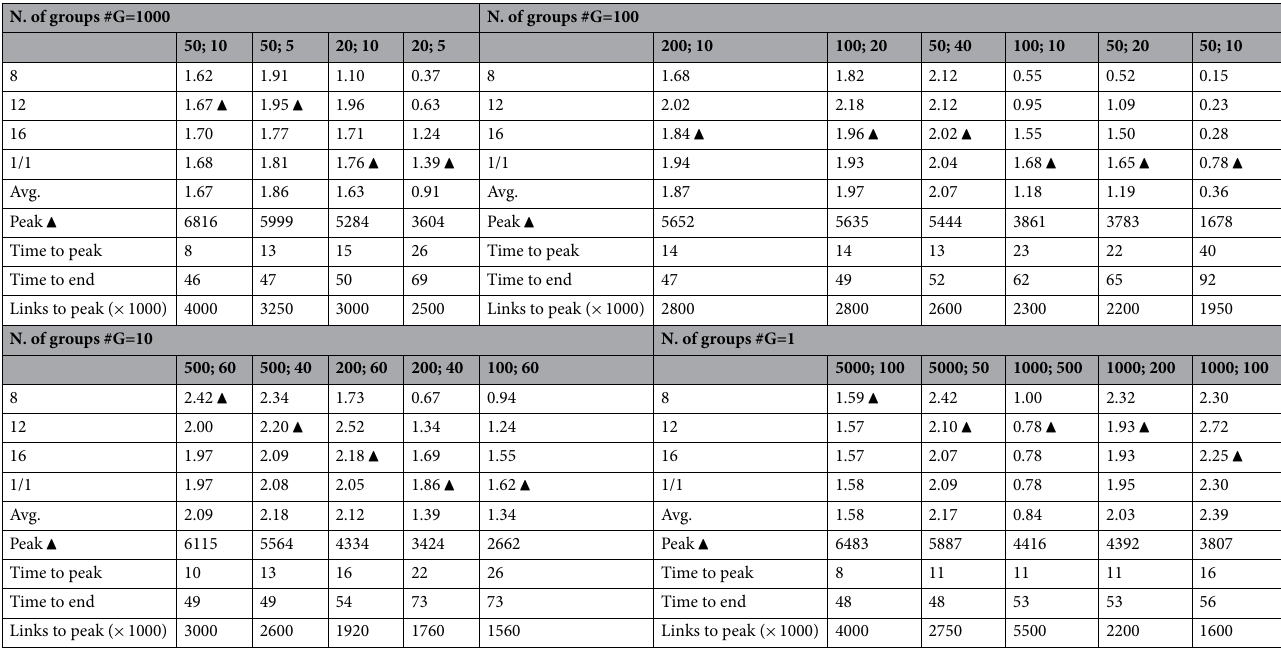
Table 1. Configurations are categorized by number of groups # G in the four quadrants, then by series ( group size , new links per agent ) in columns, and finally by grouping patterns, here only n = ( 8, 12, 16 ) and f = 1 / 1 , in rows. The values of the first four rows are those of the K Eff ( × 1000 ) efficiency metric, with average efficiency of the ephemeral grouping process in the fifth row. The black triangle ( (cid:31) ) corresponds to the grouping pattern that reached first the peak for each configuration. The last four rows of each quadrant are referred to the pattern with the black triangle (cid:31) and show: the peak value, the two time based metrics time to peak and time to end , and links to peak ( × 1000), representing the number of links ( × 1000) produced by groups from start of grouping to peak. For example, first model configuration of the first quadrant (50:10 of #G=1000): the (cid:31) is on the row corresponding to grouping pattern n = 12 , therefore values of the last four lines should be meant as referred to that